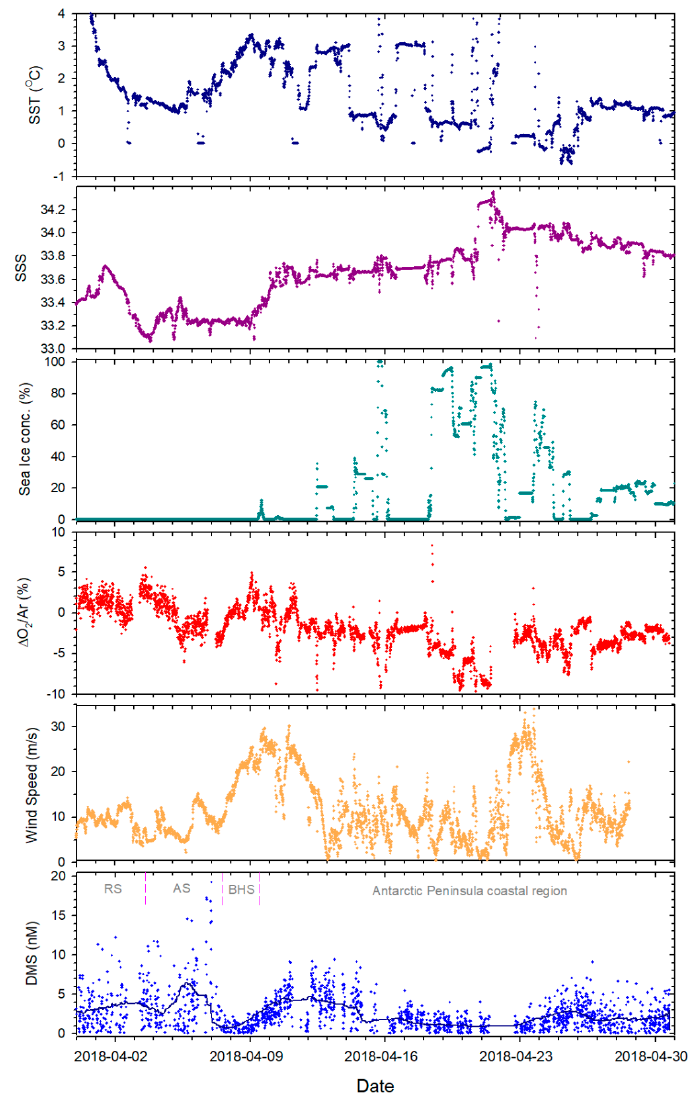
Figure 2. Time series of underway measurements of SST, SSS, sea ice concentration, O 2 /Ar (%), wind speed, and DMS. Note that the scale of the y-axis in DMS concentrations is 20, but in fact values exceeding 20 nM were observed a total of four times (20.5, 23.6, 26.8, and 28.0 nM). For the Amundsen Sea region, see Supplementary Materials. Line plots in the DMS indicate (24 h) the moving average of DMS